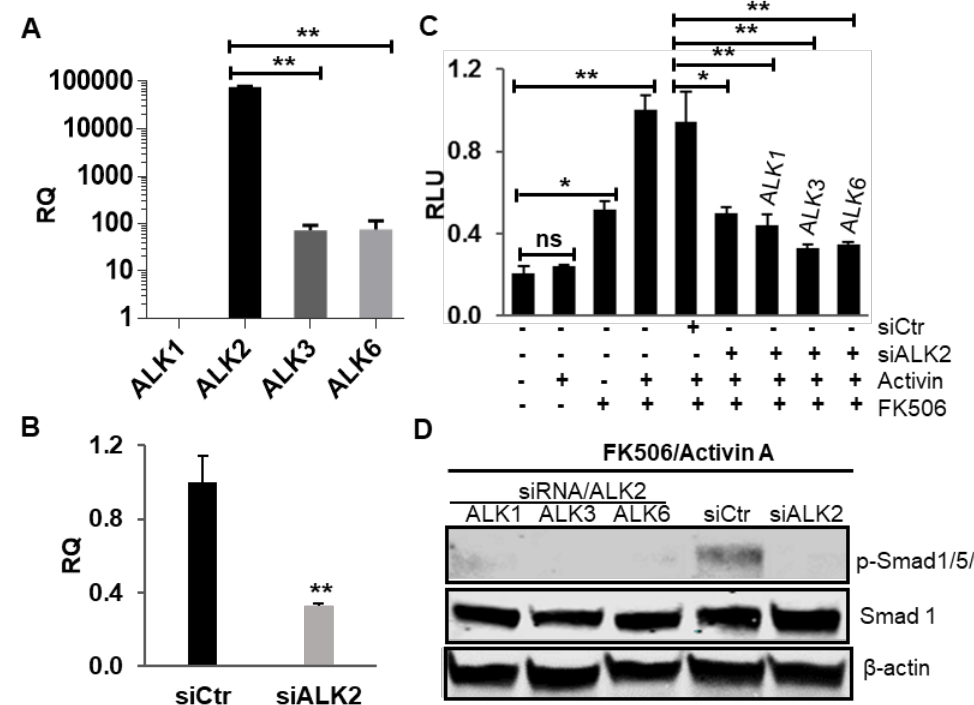
Figure 4. Only BMP type I receptor subtype ALK2, but not ALK1/3/6, is able to mediate activin A- induced BMP signaling upon FKBP12 dissociation. ( A ) RT-PCR confirmed that ALK2 is the only predominately expressed BMP type I receptor subtype in HepG2BRA cells and only a trace amount of ALK3 and ALK6 can be detected (note: the y axis is in log scale). The expression level of ALK1